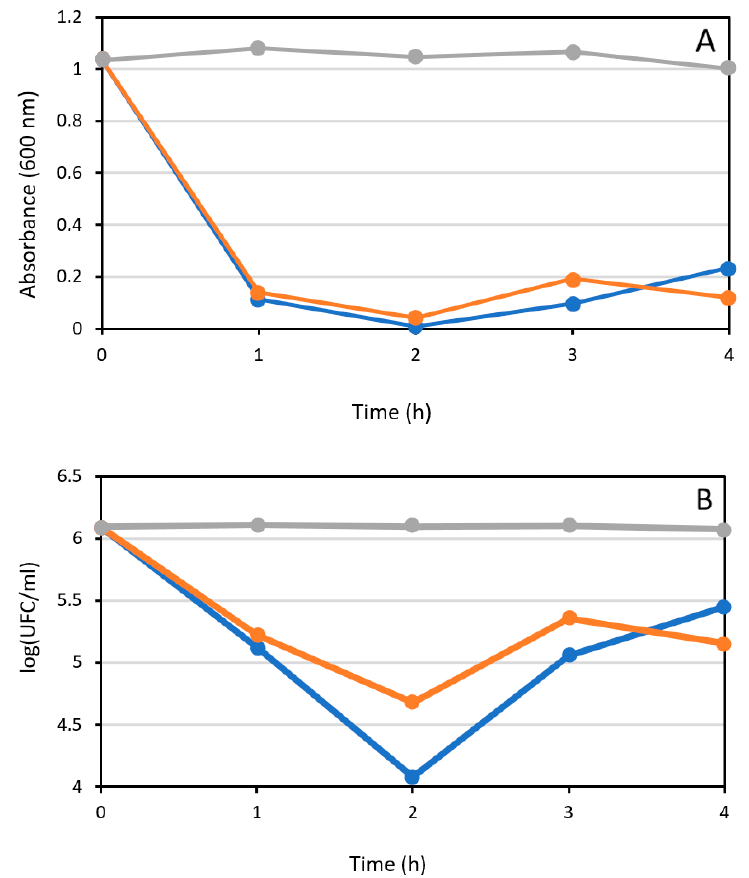
Figure 12. Adsorption kinetics of Salmonella on palygorskite and pal-PCH measured in absorbance ( A ) and concentration ( B ). The three treatments are control (grey line), palygorskite (blue line) and pal-PCH (orange line).